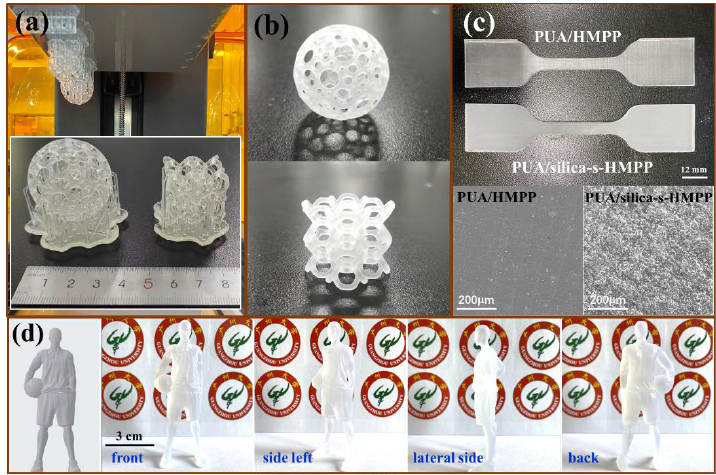
Figure 6. Digital photos of 3D printed objects (PUA/silica-s-HMPP system) acquired ( a ) during the printing process, and ( b ) after cleaning in isopropanol firstly and then post-cured by UV-irradiation. ( c ) Digital photo and SEM images of the surface finish of the PUA/HMPP and the PUA/silica-s- HMPP system 3D printed objects. ( d ) A 3D model and digital photos of 3D printed object of Sakuragi Hanamichi standing in different directions (printed by the photosensitive resin of the PUA/silica-s- HMPP system), respectively.